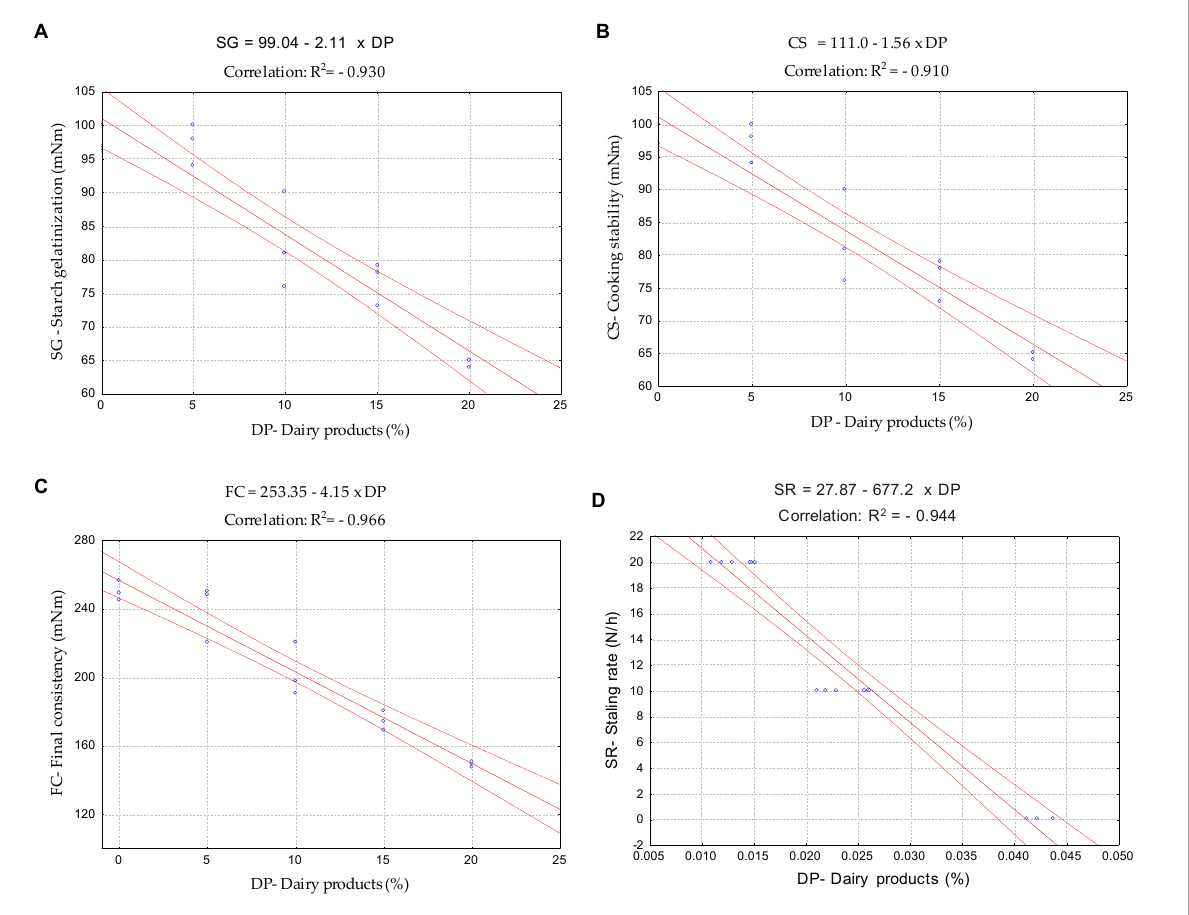
FIGURE6 Linear correlation between starch gelatinization (SG), cooking stability (CS), final consistency (FC), and staling rate (SR) with the addition of both dairy product (DP): (A) SG vs. DP; (B) CS vs. DP; (C) FC vs. DP; (D) SR vs.